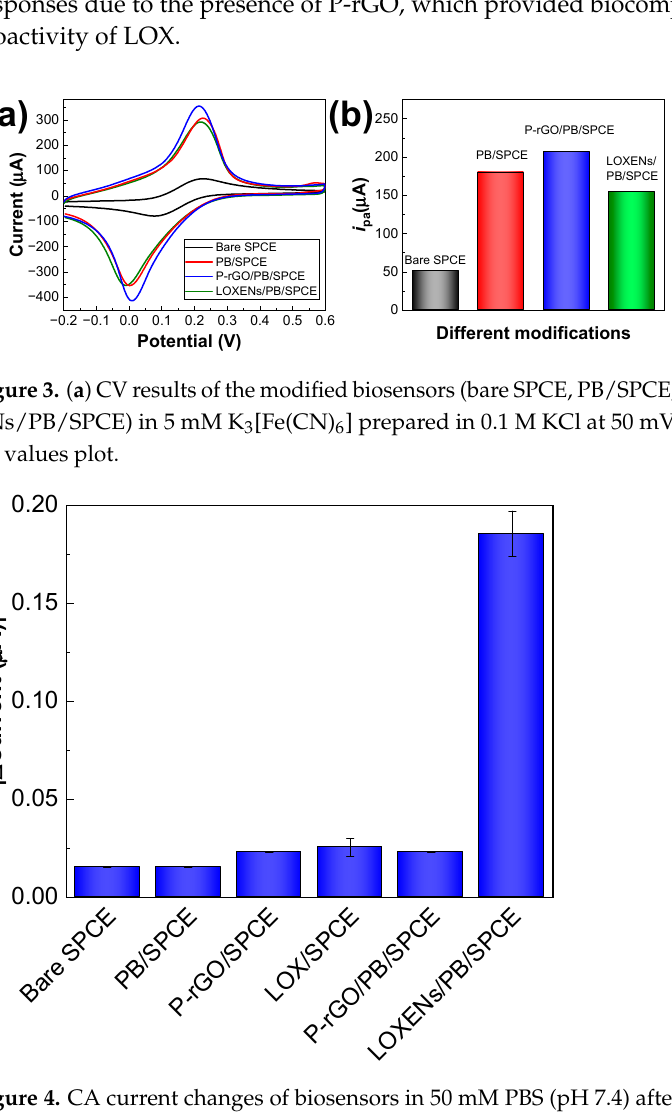
Figure 4. CA current changes of biosensors in 50 mM PBS (pH 7.4) after adding 100 µM lactate.